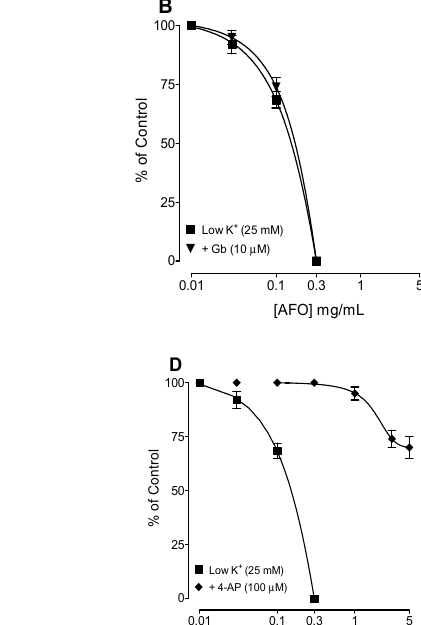
Figure 5. Concentration-response curves of Ca ++ in the absence and presence of the increasing concentrations of the ( A ) essential oil (AFO), ( B ) dicyclomine and ( C ) verapamil in isolated guinea pig tracheal preparations. Symbols represent mean ± SEM; n = 5.